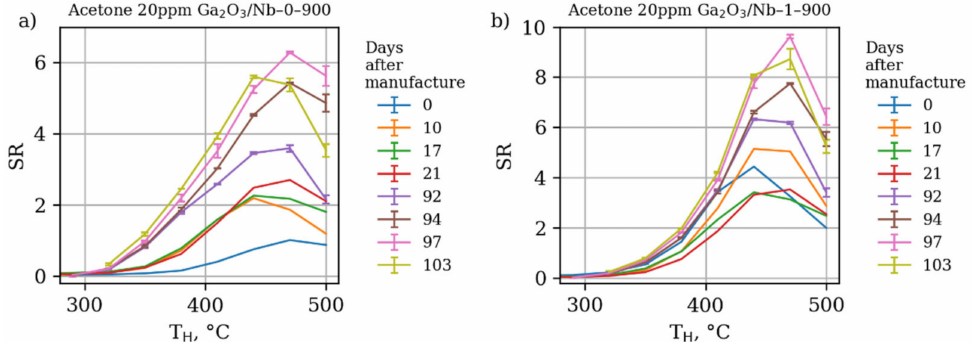
Figure 12. Dependence of sensor response of ( a ) pure Ga 2 O 3 -based materials annealed at 900 ◦ C and ( b ) 1% mol Nb-doped Ga 2 O 3 -based materials annealed at 900 ◦ C at different working temperatures towards acetone 20 ppm in dry air at different days after manufacturing and start of gas sensor response study. The sensors were busy in the 300–500 ◦ C working temperature range almost every day since the first day of operation.